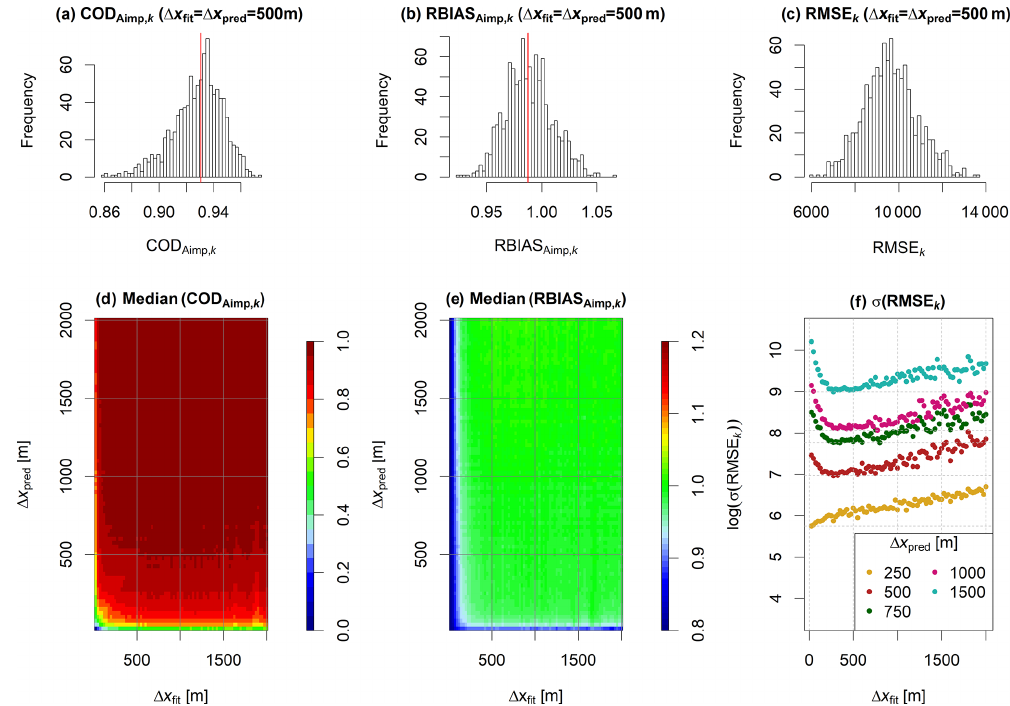
Figure 4. Results for regression models for impervious areas. Panels (a–c) : histograms of COD A during 1000 cross-validation iterations k for the combination of fitting resolution (cid:49)x fit = 500m and prediction resolution (cid:49)x pred = 500m. Red lines in panels (a) and (b) indicate median values. Panels (d, e) : median values of COD A combinations of (cid:49)x fit and (cid:49)x pred . Panel (f) : standard deviation (log-transformed) of RMSE k obtained for varying values of (cid:49)x fit and selected values of (cid:49)x pred (dots with varying